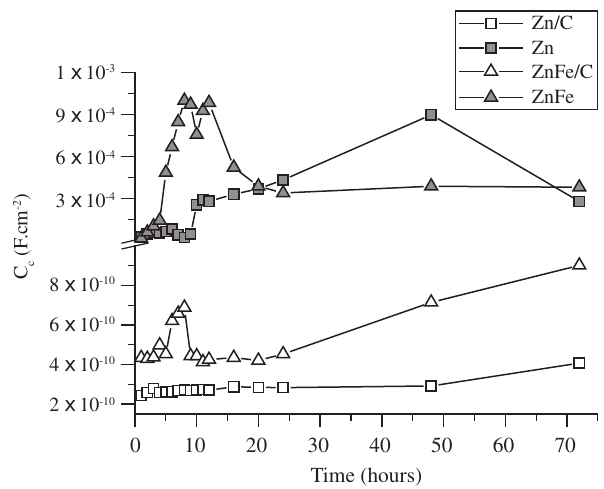
Figure 5. Time dependence of Coating capacitance for all samples.